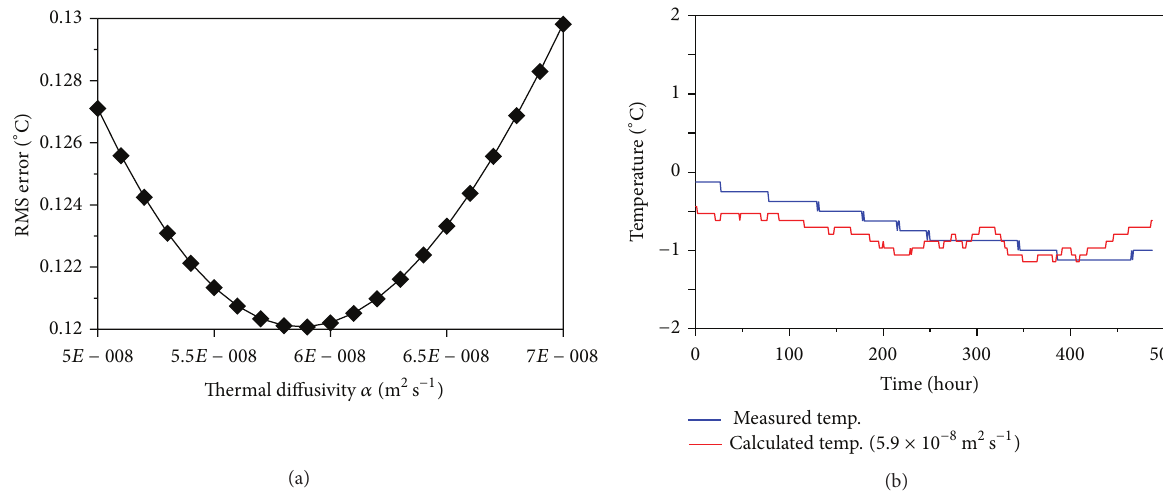
Figure 4: RMS errors between the measured and predicted temperatures to the thermal diffusivity values for (a) a soil depth of 60 cm. Panel (b) shows best fits to this data. The RMS errors were calculated using measurements taken during the period when conduction was the dominant mode of heat